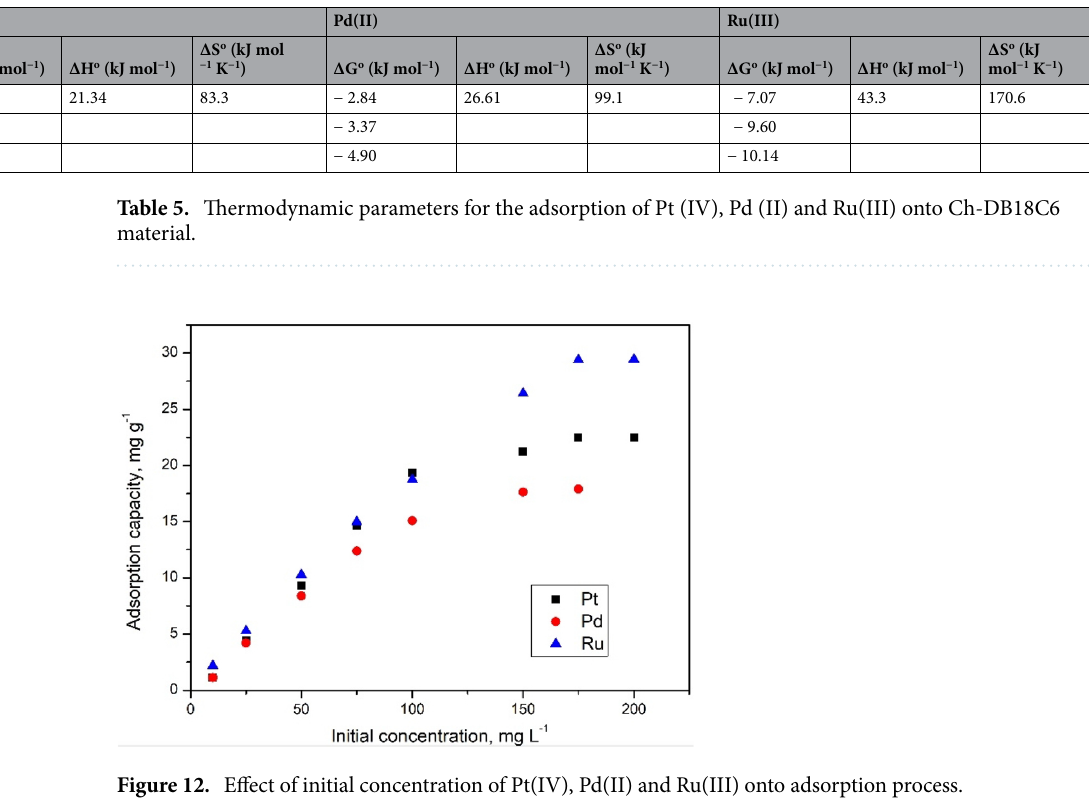
Figure 12. Effect of initial concentration of Pt(IV), Pd(II) and Ru(III) onto adsorption